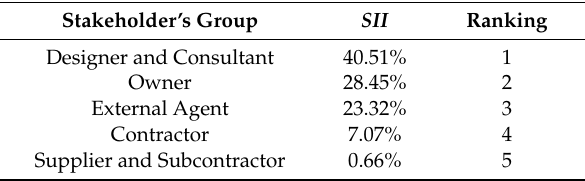
Table 9. Stakeholder Influence Index